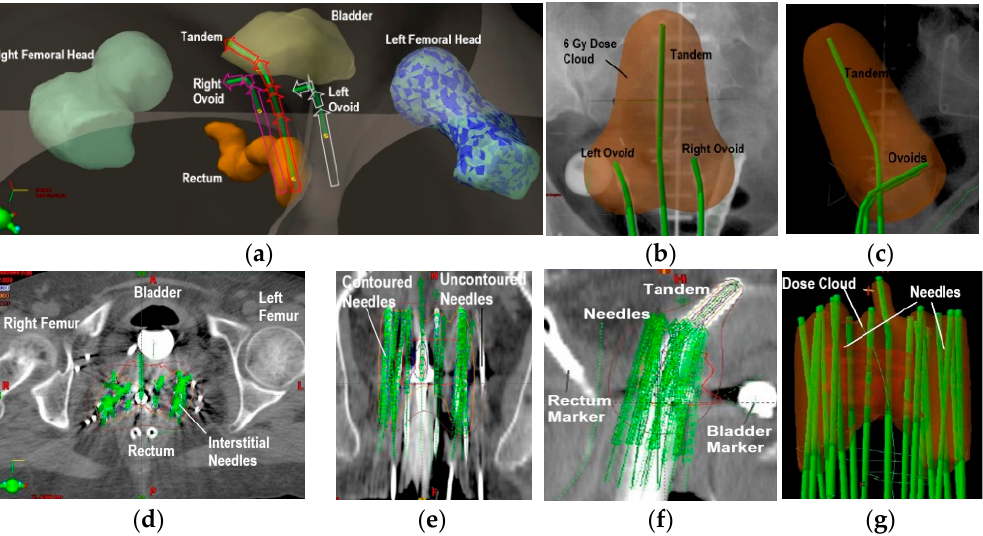
Figure 4. Three-dimensional computer rendering of a tandem-and-ovoids brachytherapy treatment generated from a patient’s CT scan. Femoral heads, bladder, and rectum structures are depicted. The arrows in the green structures indicate the radiation treatment is administered with the source at the most distal dwell position (or farthest inside the applicator) first per applicator channel ( a ). A calculated 6 Gy prescription dose distribution (pear shape) for a tandem-and-ovoids (green structures) is shown in a coronal ( b ) and sagittal views ( c ). Axial CT image depicting interstitial brachytherapy needles for cervical cancer treatment ( d ). Coronal ( e ) and sagittal images ( f ) are also shown. Depiction of a 6 Gy prescription dose calculated from the dose contribution of all the interstitial needle channels ( g ).